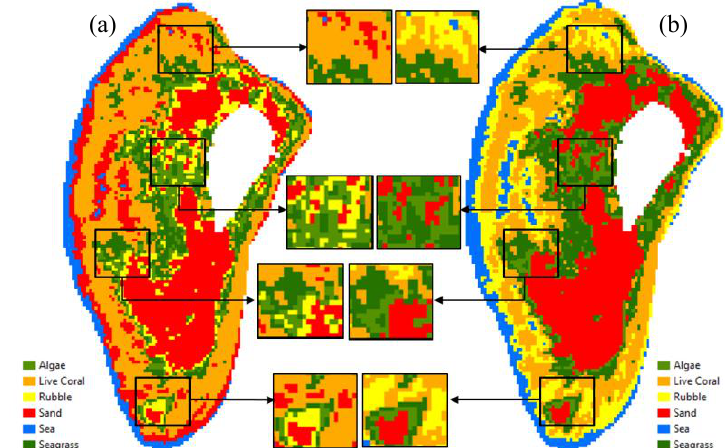
Figure 5. Differences in reclassification results with the IsoData and K-Means method on Sentinel-2 images. (a) The results of reclassification using the IsoData method, (b) The results of reclassification using the K-Means method. There are 40 points scattered on Barrang Caddi Island where these points represent each classes with each of the 4 replications (a, b, c, d) formed from the results of unguided image classification. Accuracy tests are carried out on each classification method, IsoData and K-Means methods. Based